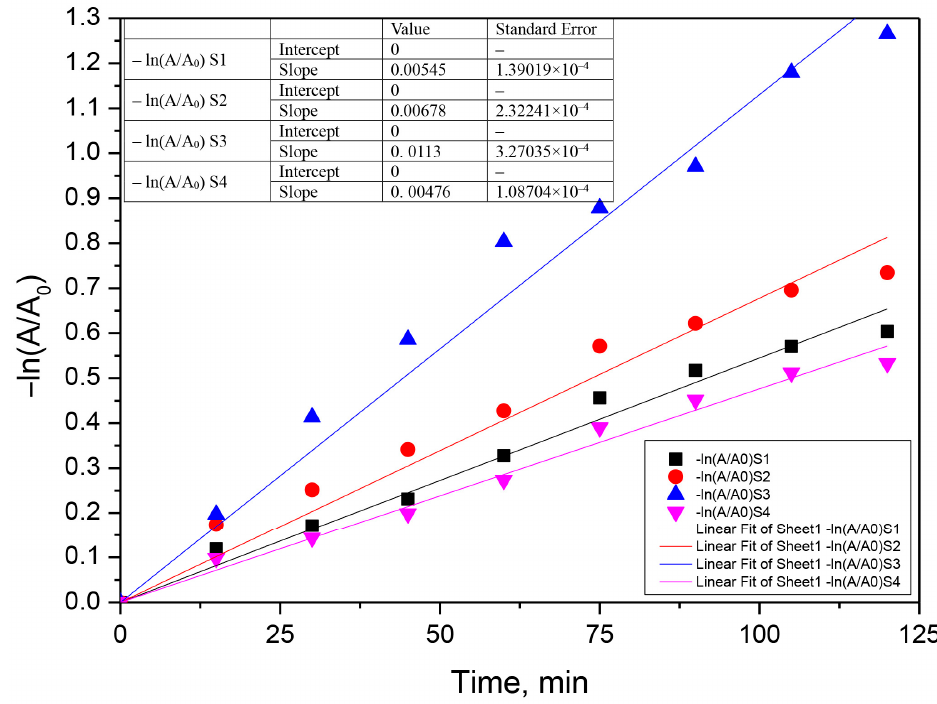
Figure 12. Fits of the pseudo-first-order kinetic model for the photocatalytic chlortetracycline + ceftriaxone mixture degradation using the S1–S4 photocatalyst (0.05 g · L − 1 , chlortetracycline concentration 0.025 g · L − 1 , ceftriaxone concentration 0.05 g · L − 1 ).